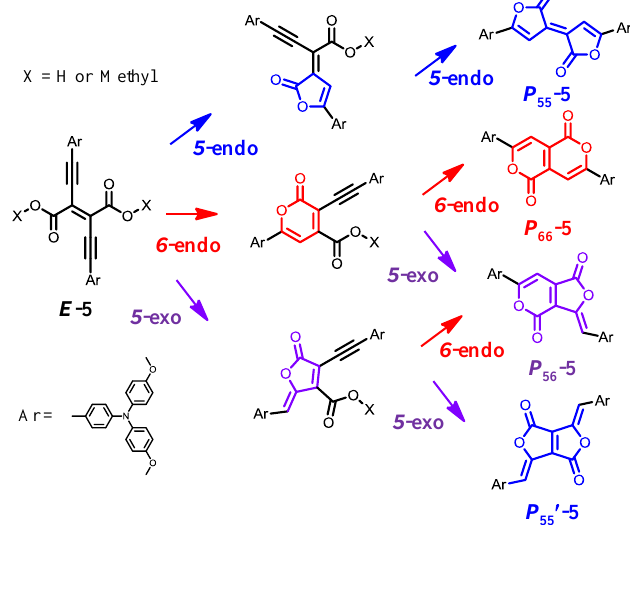
-5  toluene , ( b ) P -5 , and ( c ) P - 5 with thermal 55 66 56 - 5 comprises two disordered structures. 56